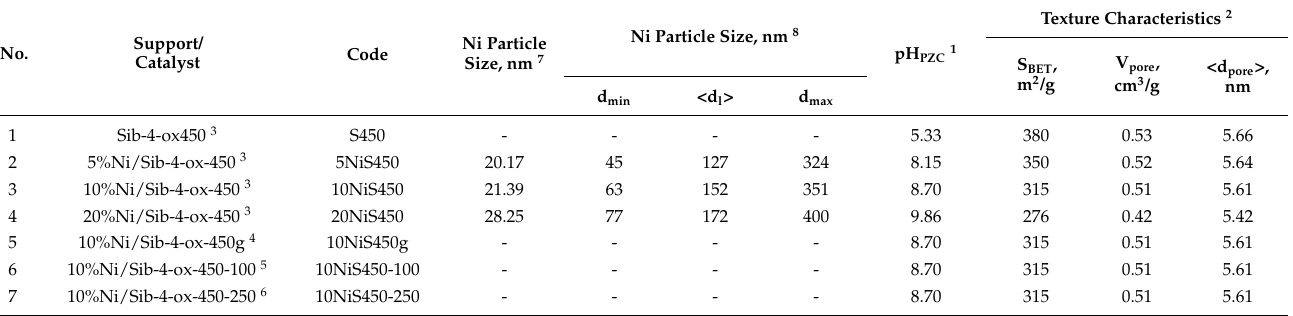
Table 1. Characteristics of the carbon support and nickel catalysts based on